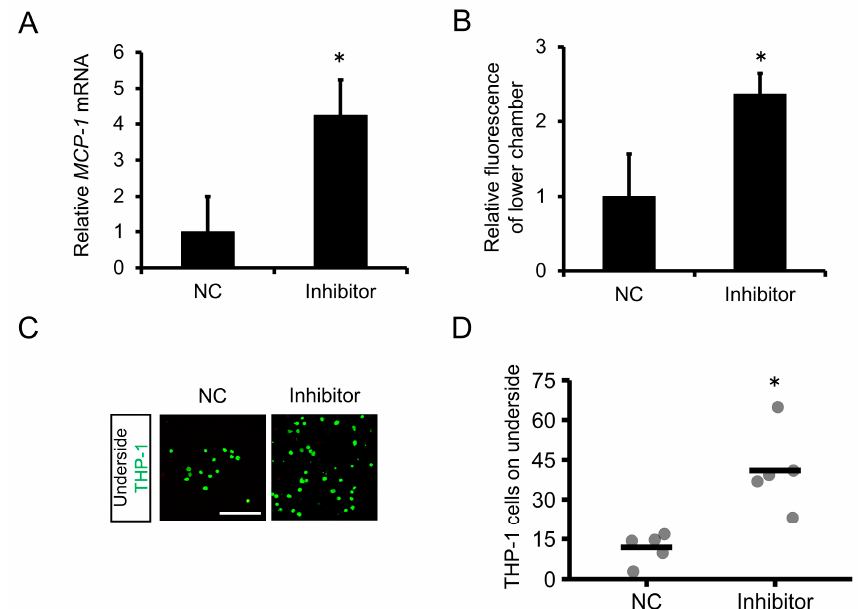
Figure 3. Effect of miR-1914-5p inhibitor on transmigration of monocytes through an endothelial cell layer. ( A ) THP-1 cells were transfected with miR-1914-5p inhibitor or NC for 24 h, and MCP-1 gene expression was examined by qRT-PCR. n = 3 in each group. * p < 0.05 compared with the NC transfected group. ( B ) Monocyte transmigration through the endothelial cell layer was examined using a transmigration assay after transfection with miR-1914-5p inhibitor or NC for 24 h. Transmigration of THP-1 cells through the endothelial cell layer into the lower chamber was assessed by comparing the relative fluorescence intensity of the upper and lower chambers using a microplate reader. n = 3 in each group. * p < 0.05 compared with the NC transfected group. ( C ) Fluorescent images of the top and underside of the membrane. THP-1 cells were labeled with the fluorescent dye BCECF-AM (green). Scale bar represents 100 μ m. ( D ) The number of fluorescent THP-1 monocytes on the underside of the membrane was determined. n = 5 fields in each group. * p < 0.05 compared with the NC transfected group.